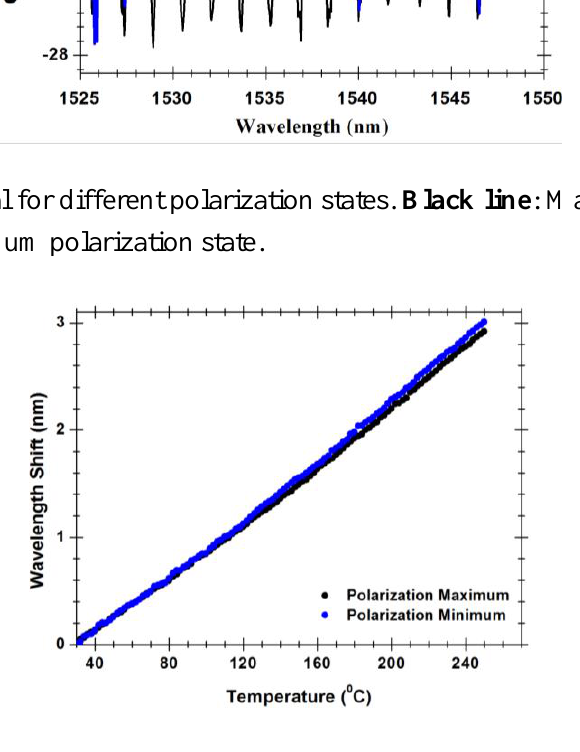
Figure 8. Wavelength shift of the hybrid low finesse Fabry-Pérot interferometer with the temperature for polarization maximum and